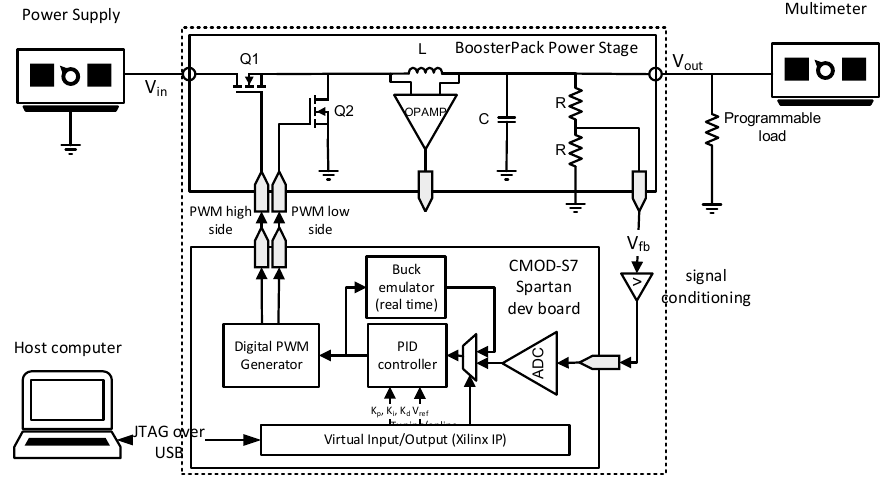
Figure 9. Experimental setup for buck converter characterization and measurements.